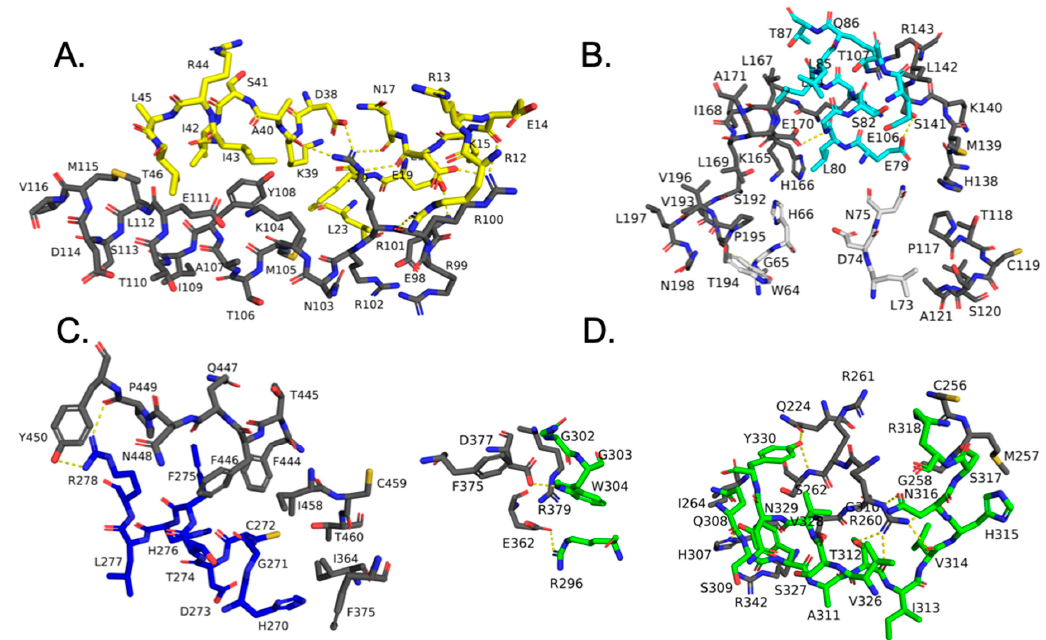
Figure 2. Modeling of the ARNT: SIM1 heterodimeric complex interaction interfaces. SIM1 domain carbons are colored per Figure 1A and residues labeled. Polar contacts between SIM1 and ARNT are shown as yellow dashes. Global context of the complex is given in Figure 1. ( A ) bHLH SIM1 domain interactions with ARNT are displayed, as described in Section 3.1.1. The SIM1 bHLH domain is colored yellow and ARNT is given in black carbons. ( B ) PASA SIM1 domain interactions with ARNT are presented, as described in Section 3.1.2. The SIM1 PASA domain is colored cyan or white and ARNT is given in black carbons. ( C ) PASB SIM1 domain interactions with ARNT are shown, as described in Section 3.1.3. The SIM1 PASB domain is colored blue and ARNT is given in black carbons. ( D ) PAC SIM1 domain interactions with ARNT are exhibited, as described in Section 3.1.4. The SIM1 PAC domain is colored green and ARNT is given in black carbons.